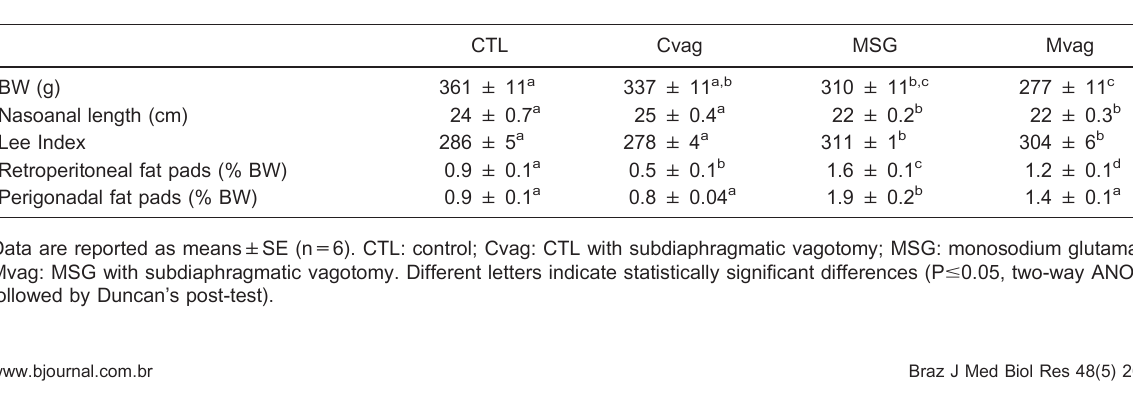
Table 1. Final body weight (BW), nasoanal length, Lee Index, retroperitoneal and perigonadal fat pads of 90-day old CTL, Cvag, MSG and Mvag